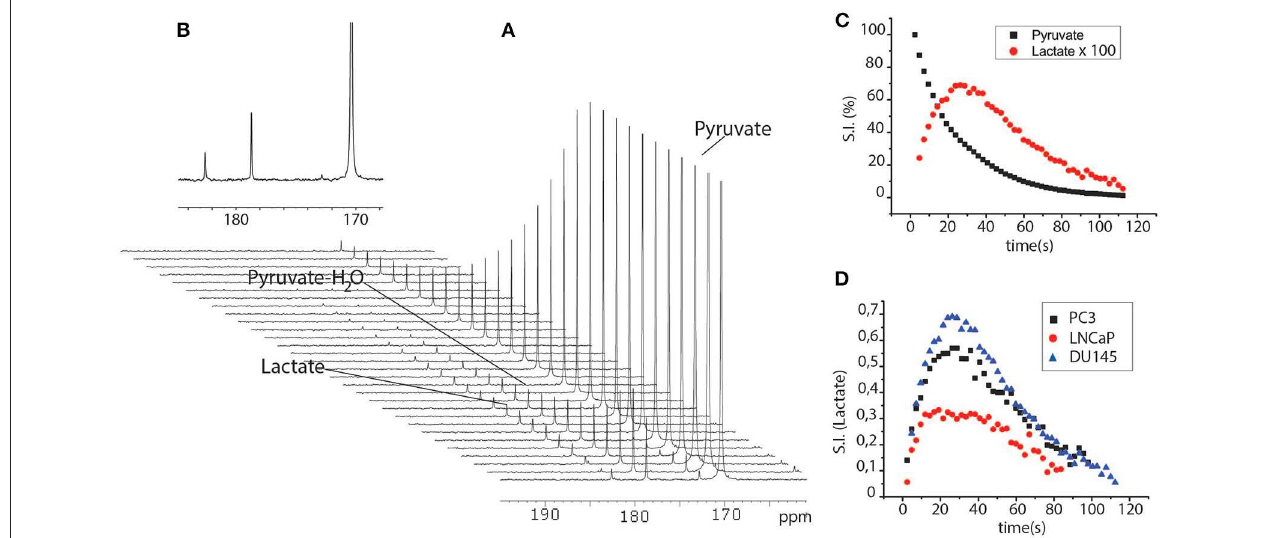
FIGURE 4 | (A) series of 13 C-NMR spectra acquired after the perfusion of a cells suspension (PC3 cells, 10M) with the aqueous solution HP-[1- 13 C]pyruvate. Spectra were acquired using small flip angle pulse (18 ◦ ) and 2s delays between one scan and another. (B) expanded 13 C-NMR spectrum at maximum intensity of the lactate signal; (C) Time dependent pyruvate and lactate curves obtained from the integrals of the signals of the two metabolites in the 13 C-NMR spectra reported in (A) . (D) time dependent lactate curves obtained after the addition of HP-pyruvate to a suspension of DU145, PC3, and LNCaP cells.